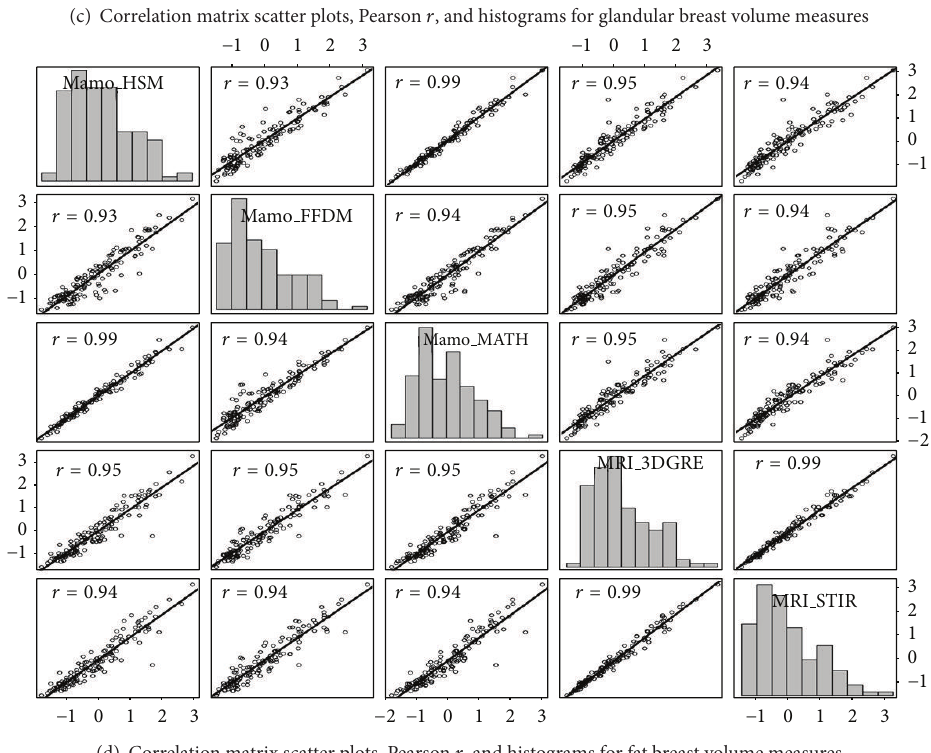
(d) Correlation matrix scatter plots, Pearson 𝑟 , and histograms for fat breast volume measures Figure 2: (a)–(d) Scatter plot matrix including Pearson 𝑟 and regression line for pairwise correlation analyses between %-breast density (a), fibroglandular tissue volumes (b), adipose tissue volumes (c), and total breast tissue volumes (d) measured by five different methods. Diagonal boxes show histograms for each variable. Mamo HSM (1st row and 1st column), histogram segmentation method using mammograms; Mamo FFDM (2nd row and 2nd column), mammograms from full field digital mammography; Mamo MATH (3rd row and 3rd column), mathematical algorithm for computing breast tissue content using mammograms; MRI 3DGRE (4th row and 4th column), 3-dimensional gradient-echopulsesequenceusingMRIimages;MRI STIR(5throwand5thcolumn),shorttauinversionrecoverypulsesequenceusingMRI images. Units of measures for 𝑥 -axis and 𝑦 -axis are 𝑍 score (mean = 0, standard = 1) for (a)–(d). All data used for each pairwise correlation analysis are included within the graph ruler space. The bin width within each histogram is equally distributed within the column 𝑥 -axis scale and frequency in 𝑦 -axis is not labeled but represents relative distribution. For mean values, consult Figure